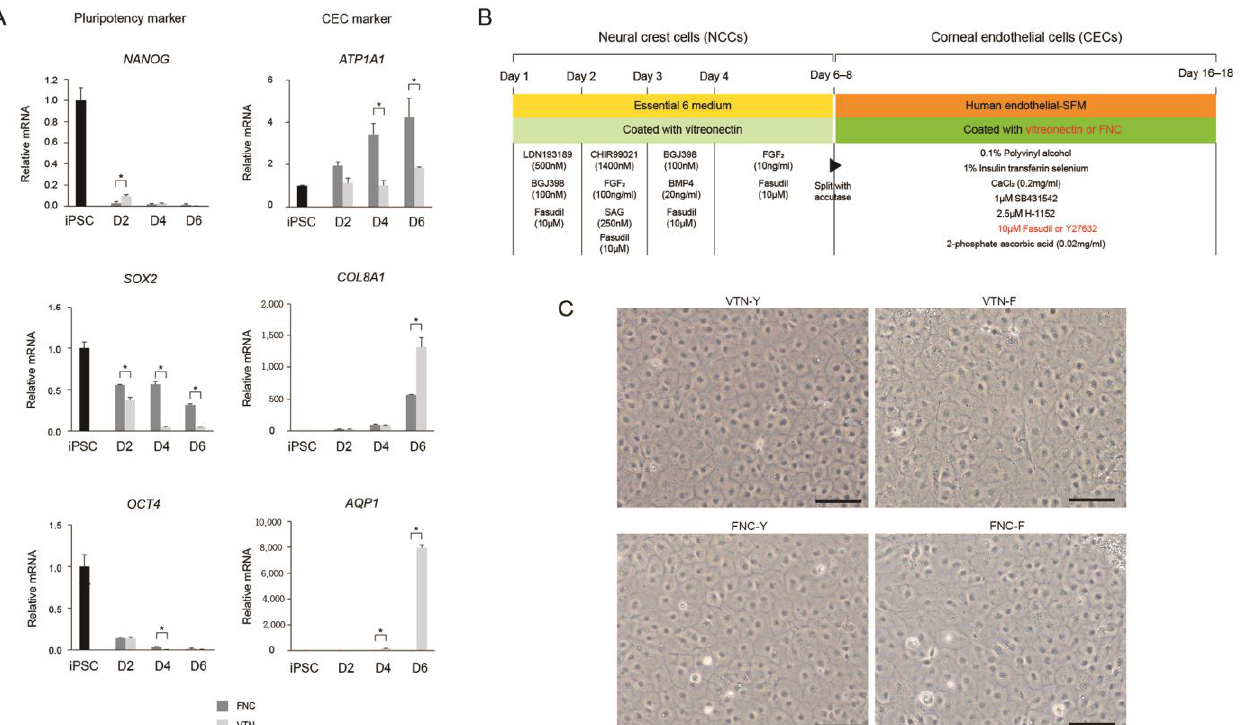
( A ) Ocular observation and numerical data at 1, 2, and 3 weeks after transplantation of iPSC-derived CECs. Compared with the non-transplanted control, cloudy corneas were clear in the transplanted eyes after 1 week and the effect increased over time (* p < 0.05; n = 6). Corneal opacity was evaluated on a scale of 0–4 (0 = none; 1 = mild turbidity, iris texture evident; 2 = moderate turbidity, iris texture unclear; 3 = severe turbidity, pupil faint; and 4 = severe turbidity, pupil not visible). ( B ) The corneal thickness of the cell transplant group was observed histologically using H & E staining. The cornea of the transplanted group ( right ) is thinner compared with the non-transplanted control group ( middle ), which closely resembled the healthy cornea ( left ). Scale bars = 200 µ m. ( C ) Immunohistochemistry for the detection of human CEC markers (ATP1A1 and ZO-1) in the corneas of transplanted and non-transplanted groups. ATP1A1 and ZO-1 were broadly expressed in the cornea of the transplant group, but not in the non-transplant control group. Scale bars = 200 or 100 µ m.